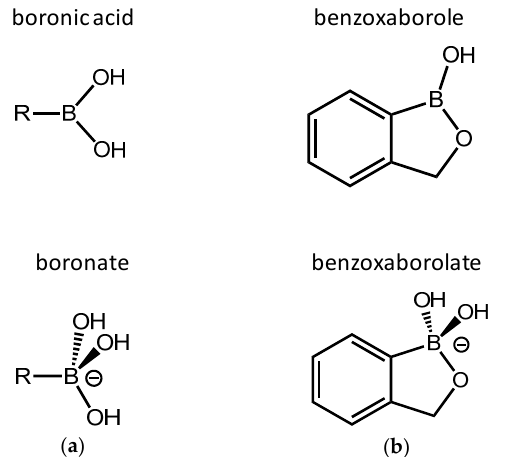
Figure 2. Representation of the structures of boronic acids/boronates ( a ), and benzoxaboroles/ benzoxaborolates ( b ). Only the tetrahedral-boron forms of boronate/benzoxaborolate anions are shown here.